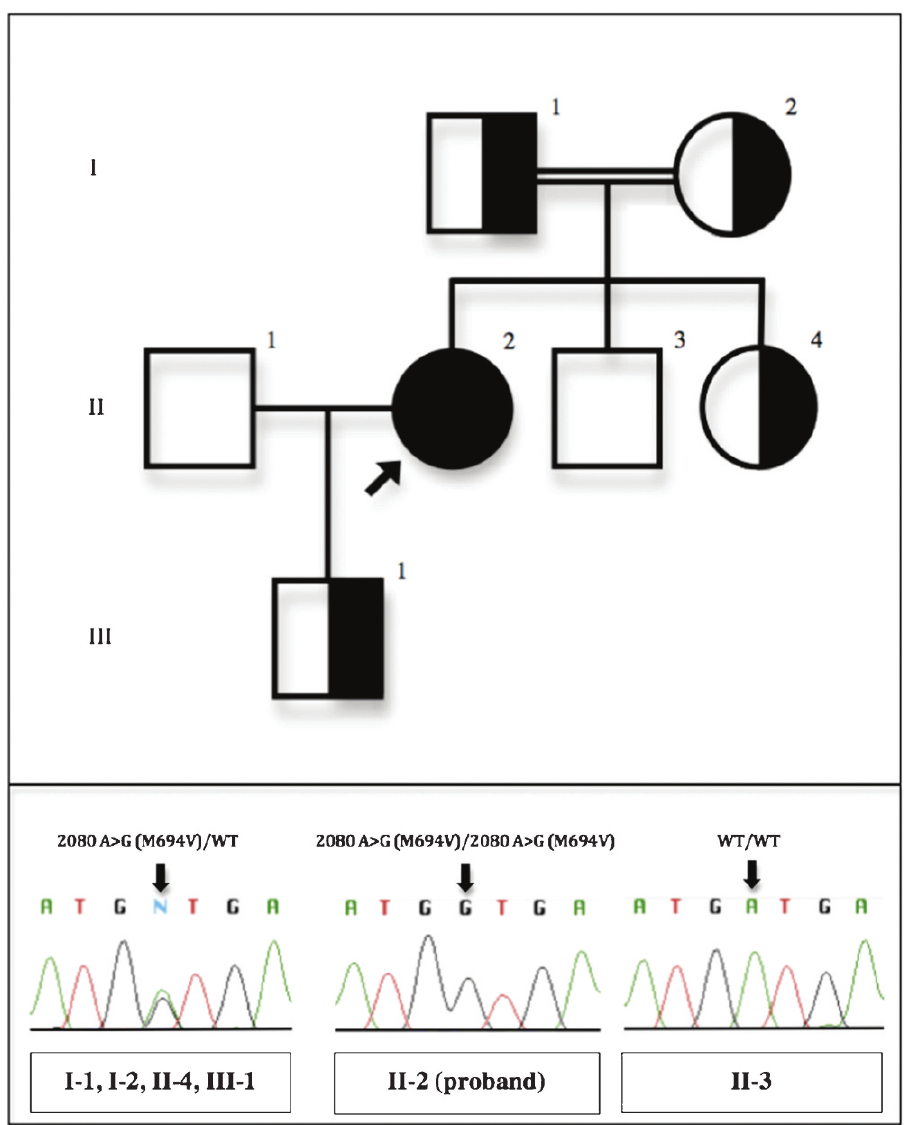
Figure 3 - Top: Family pedigree. Bottom: Individual genotypes and corresponding DNA sequence chromatograms. The nucleotide position refers to the MEFV mRNA sequence, with the A of the start codon designated as nucleotide 1. WT: wild type. Individual II-1 was